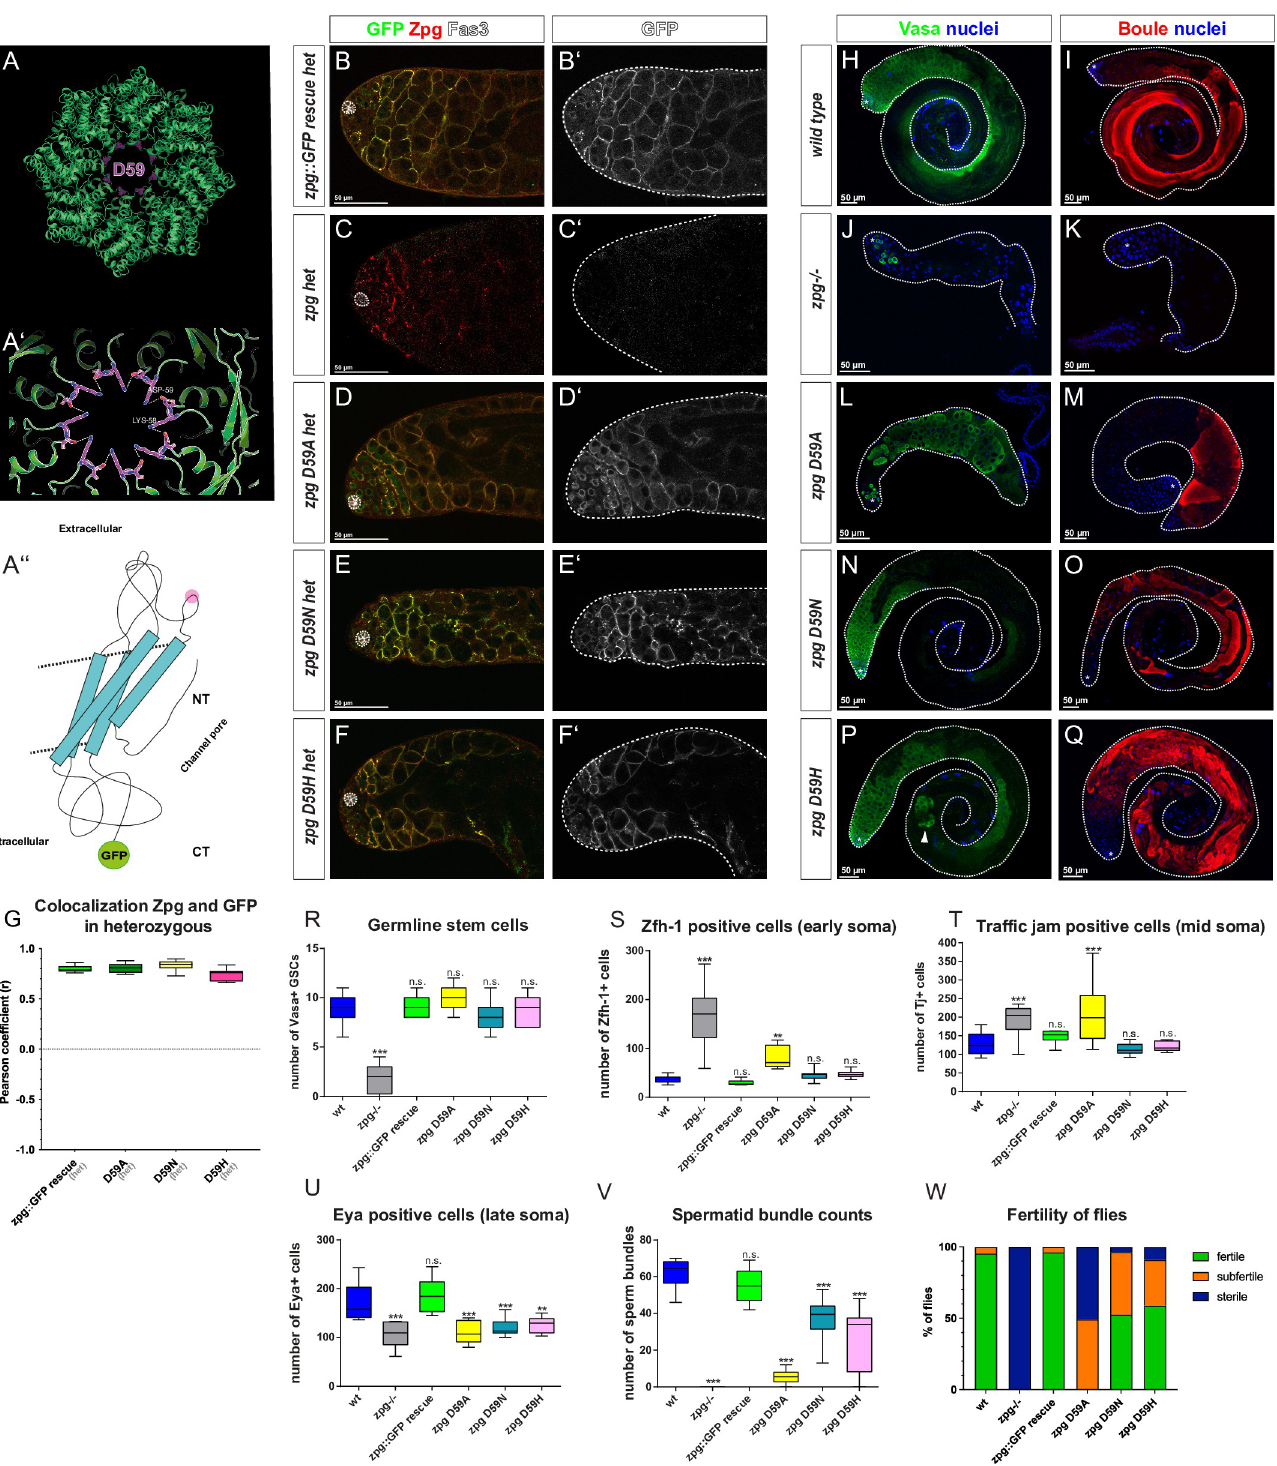
Fig 6. Mutating the residue D59 of Zpg in the channel pore results in late-stage defects in germ cell differentiation. (A) Homology model of Zpg showing the position of Aspartate 59 (D59) at the narrowest part of the channel pore, constricting its diameter. (A’) D59 is predicted to form a hydrogen bond with lysine (K58) of the neighboring Zpg subunit. (A”) Simplified model highlighting the location of D59 in the first extracellular loop of Zpg, facing inside the pore. (B-F) Colocalization of wildtype endogenous Zpg and GFP-tagged, mutated Zpg. Flies heterozygous for a null allele of zpg but also containing one copy of the wildtype genomic zpg rescue construct ( zpg GFP::GR; B-B’), no rescue construct (C-C’), one copy of the zpg D59A mutant rescue construct (D-D’), one copy of the zpg